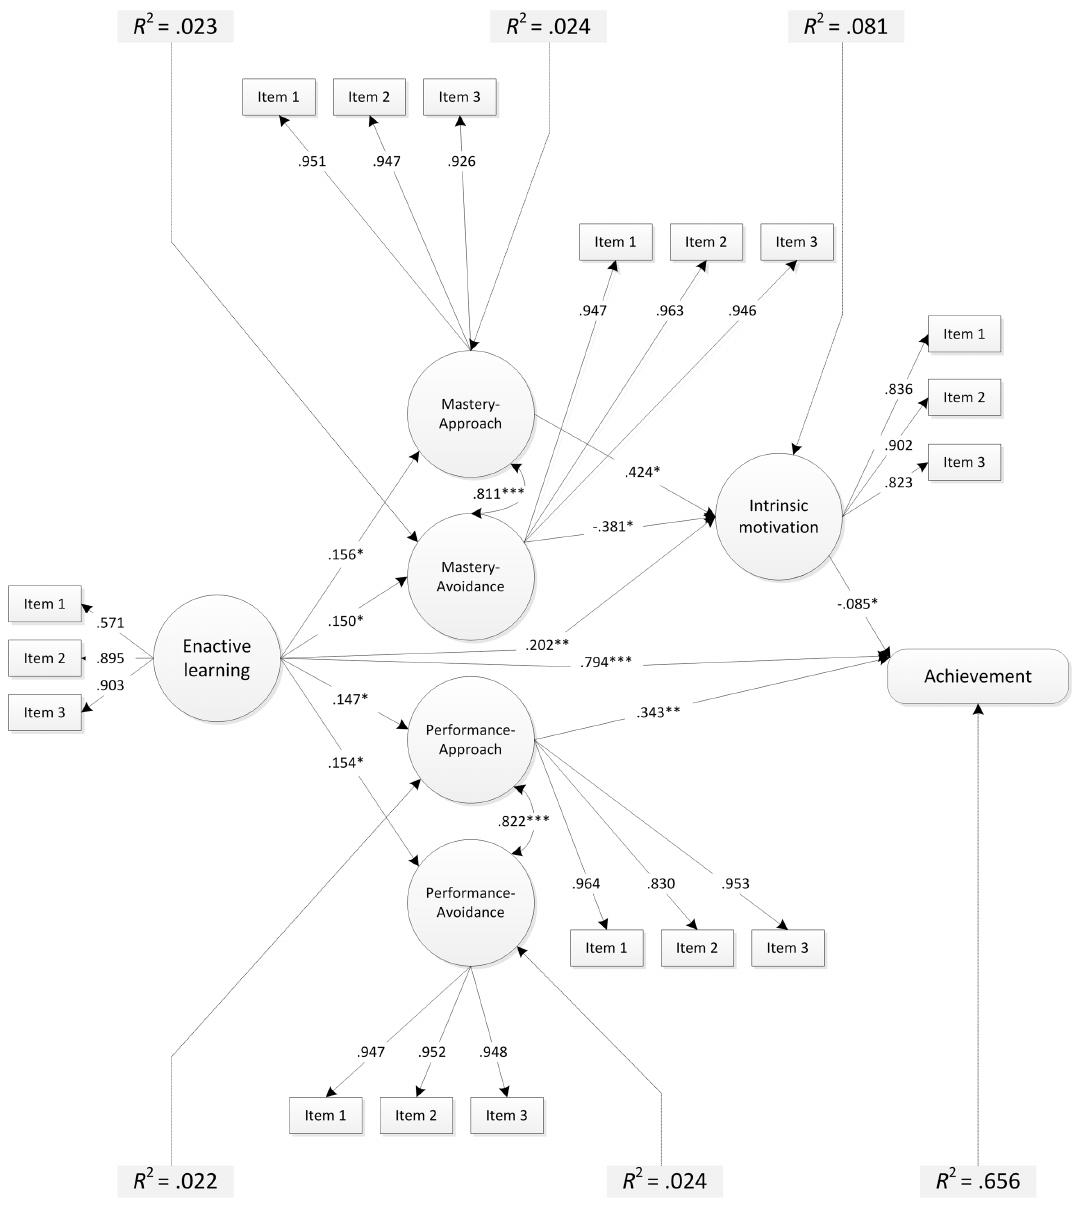
Figure 2. A final solution for antecedents and consequences of achievement goals. * p < .05. ** p < .01. *** p < .001.